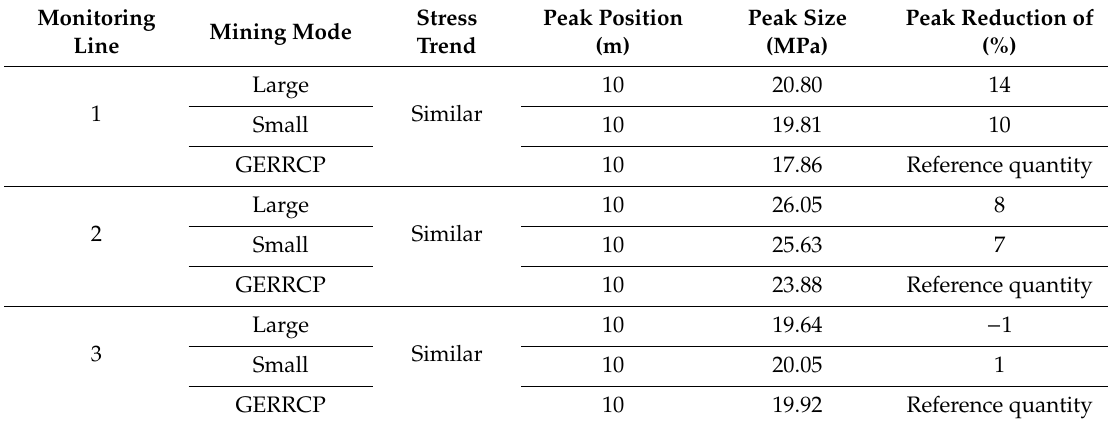
Table 3. Key parameters of the stress distribution characteristics along the working face